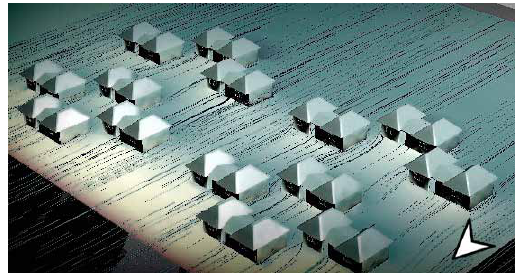
fig. 23. Model dwelling unit: a modification of existing u-shaped dwelling Source: drawn by author.